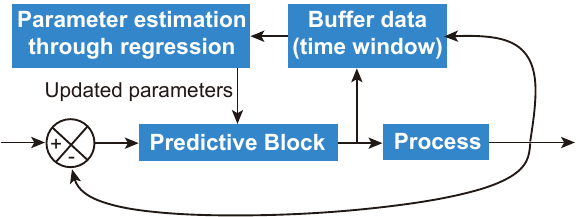
Figure 6. The adaptive autotune control recursively estimates the parameter values of the predictive model. The most important aspect of this type of control is having a sufficiently robust parameter estimation technique.